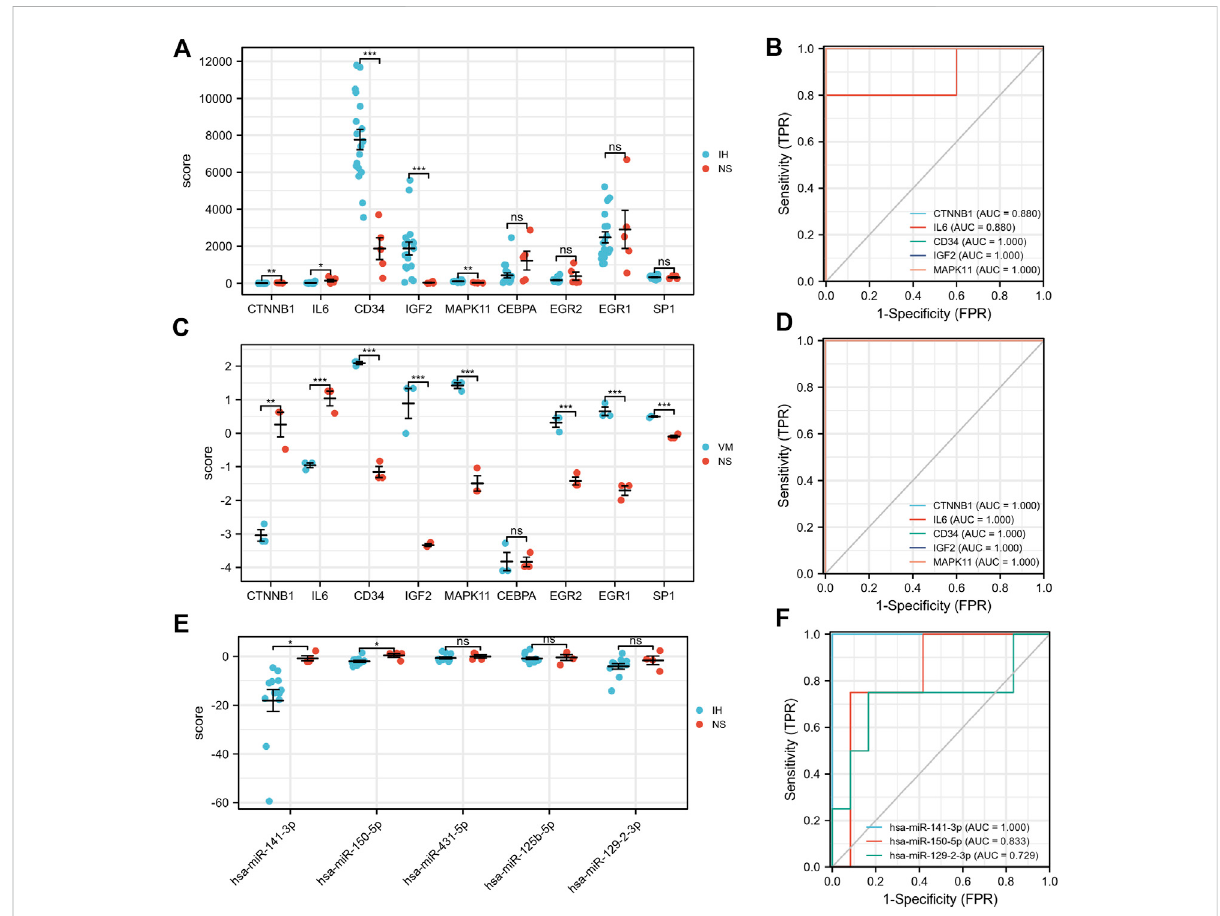
FIGURE 8 Validation of hub genes, TFs and microRNA expression and their ROC curves. * p < 0.05; ** p < 0.01; *** p <